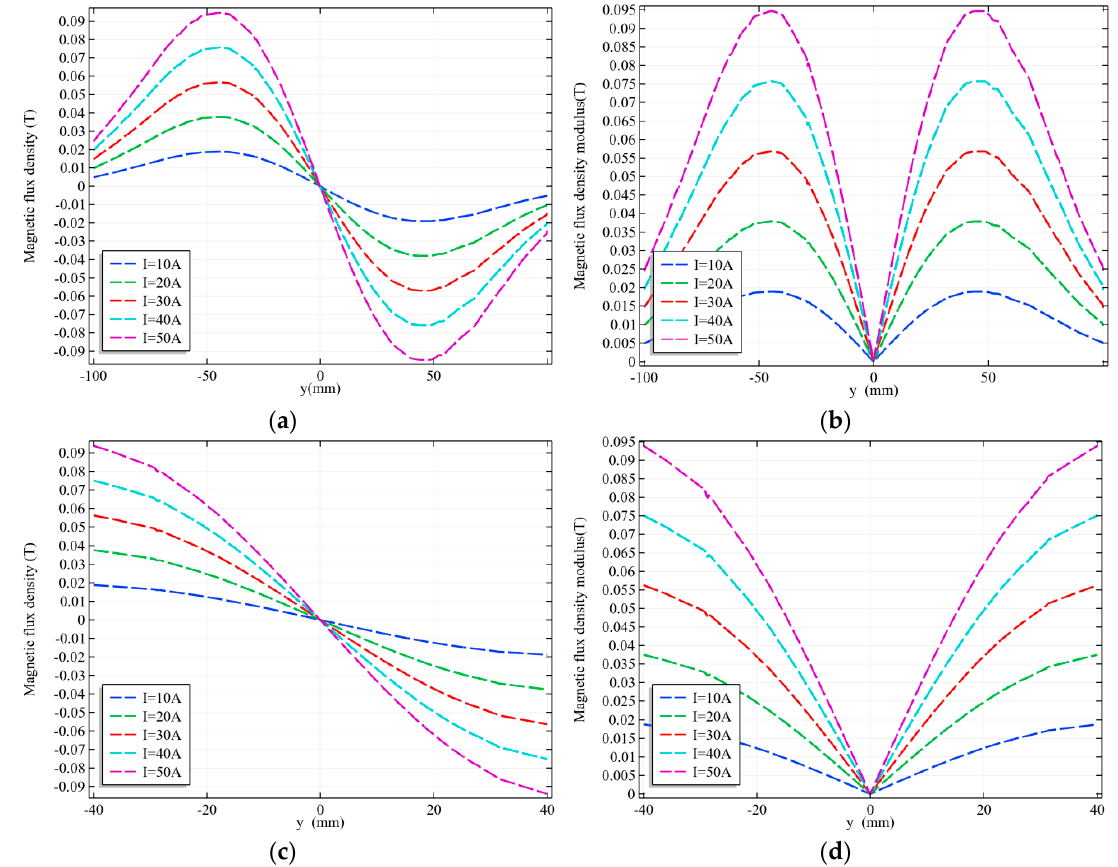
Figure 8. The linear gradient magnetic fields with different excitation currents near x = 0. ( a ) The magnetic flux density of the entire observed region; ( b ) The magnetic flux density modulus of the entire observed region; ( c ) The magnetic flux density within the radial range of the artery model; ( d ) The magnetic flux density modulus values within the radial range of the